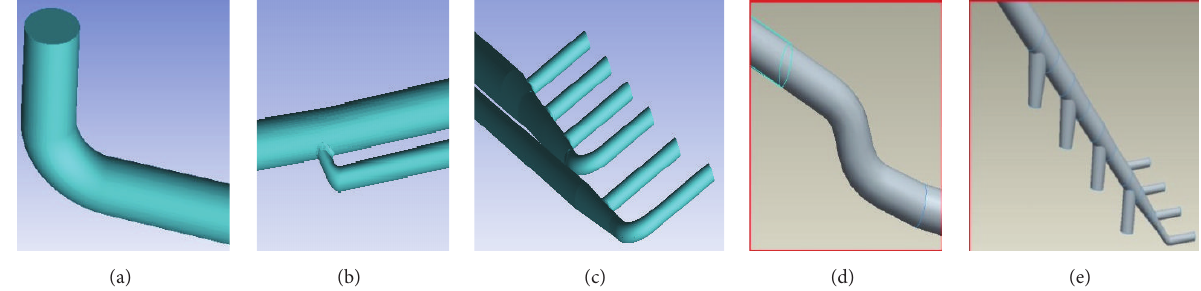
Figure 1: Modeling of Tunnel 2: (a) main bend, (b) main branch, (c) outlets: Tunnel 3, (d) S bend, and (e) outlets.